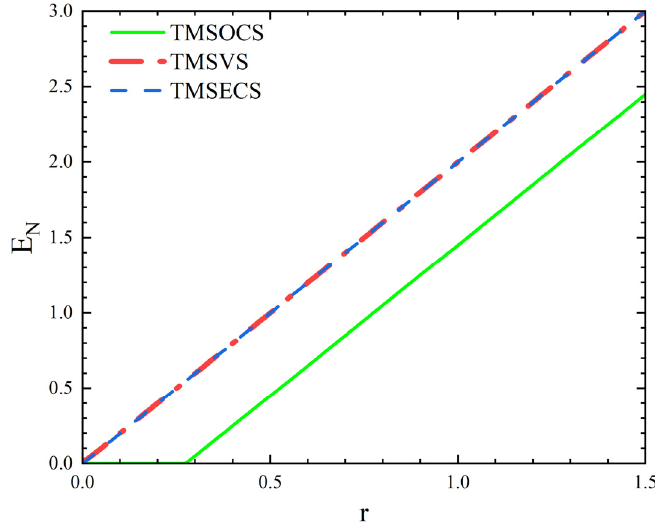
Figure 6. The logarithmic negativity of the final state for different initial states, i.e., two-mode squeezed vacuum state (TMSVS), two-mode squeezed odd coherent state (TMSOCS), two-mode squeezed even coherent state (TMSECS). Here, r denotes the squeezing strength and other parameters are chosen to be the same as those in Figures 3 and 5.